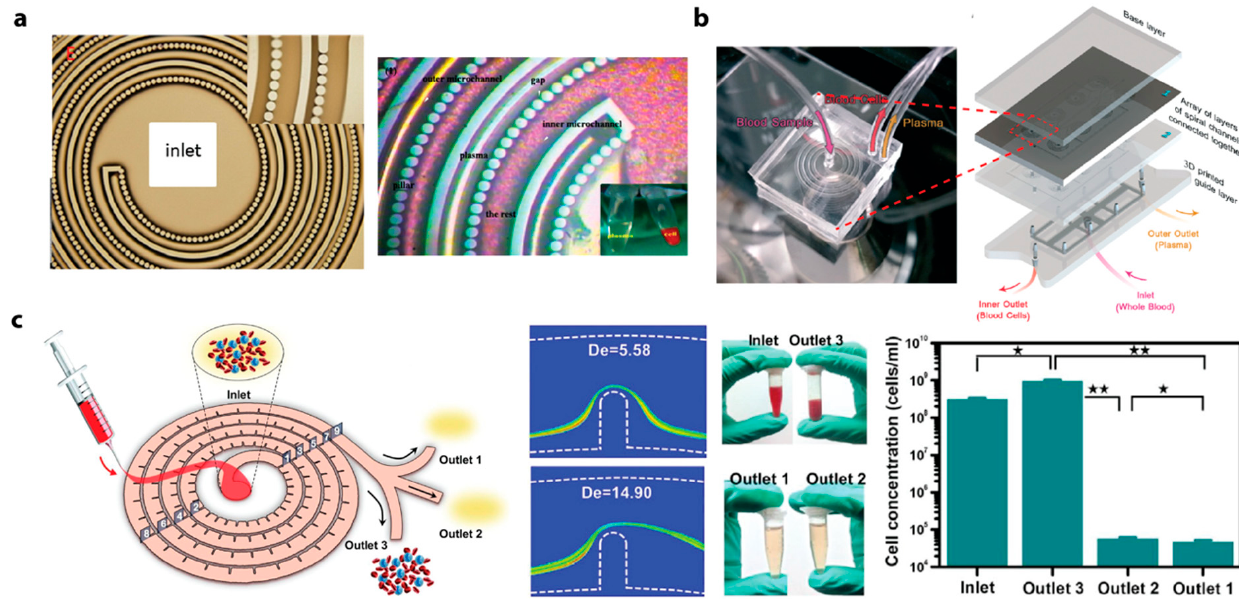
Figure 9. Inertial microfluidic devices for plasma extraction. ( a ) Micropillar filters in a spiral microchannel were used to separate cells from diluted blood. Separated plasma and concentrated blood cells are shown in the silicon microfluidic device and microcentrifuge tubes (inset figure). Adapted from [156] with permission from the author, Copyright 2013, Elsevier. ( b ) A spiral microfluidic device with the trapezoidal cross-section was effective in focusing diluted blood cells into a single stream for plasma extraction. The total 16 devices were parallelized for enhanced throughput. Adapted from [152] by permission from The Royal Society of Chemistry. ( c ) A spiral microchannel with regularly spaced microbars improved the focusing of a blood cell stream by secondary Dean-like flow. The optimized microbar shape and operating condition allowed higher purity than that reported in the authors’ previous work with unoptimized conditions [153]. A manual plasma extraction was demonstrated using a syringe (15x diluted blood),adapted from [157] with permission from the author, Copyright 2014,